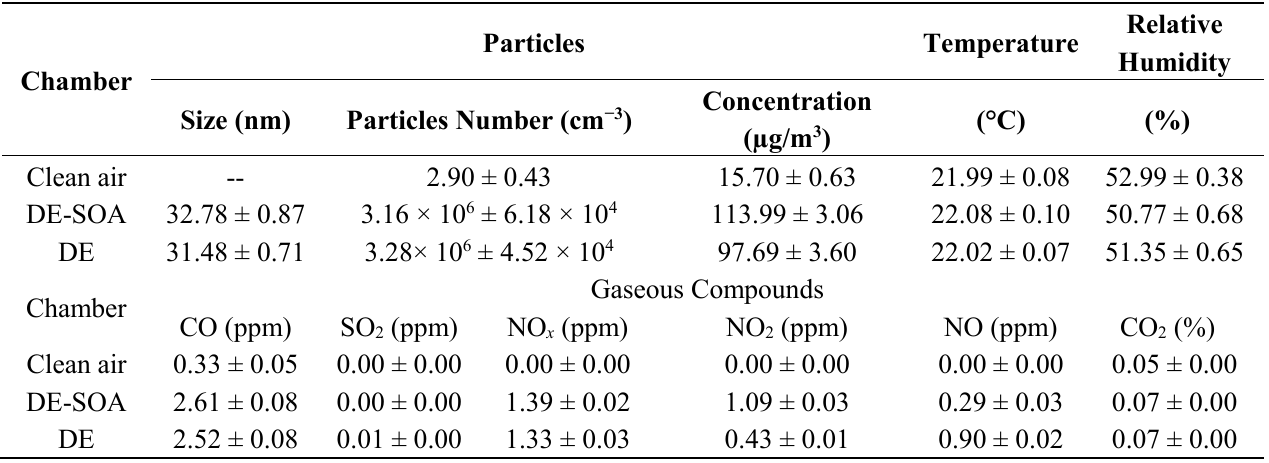
Table 1. Characterization of diesel exhaust particle and gaseous compounds in the